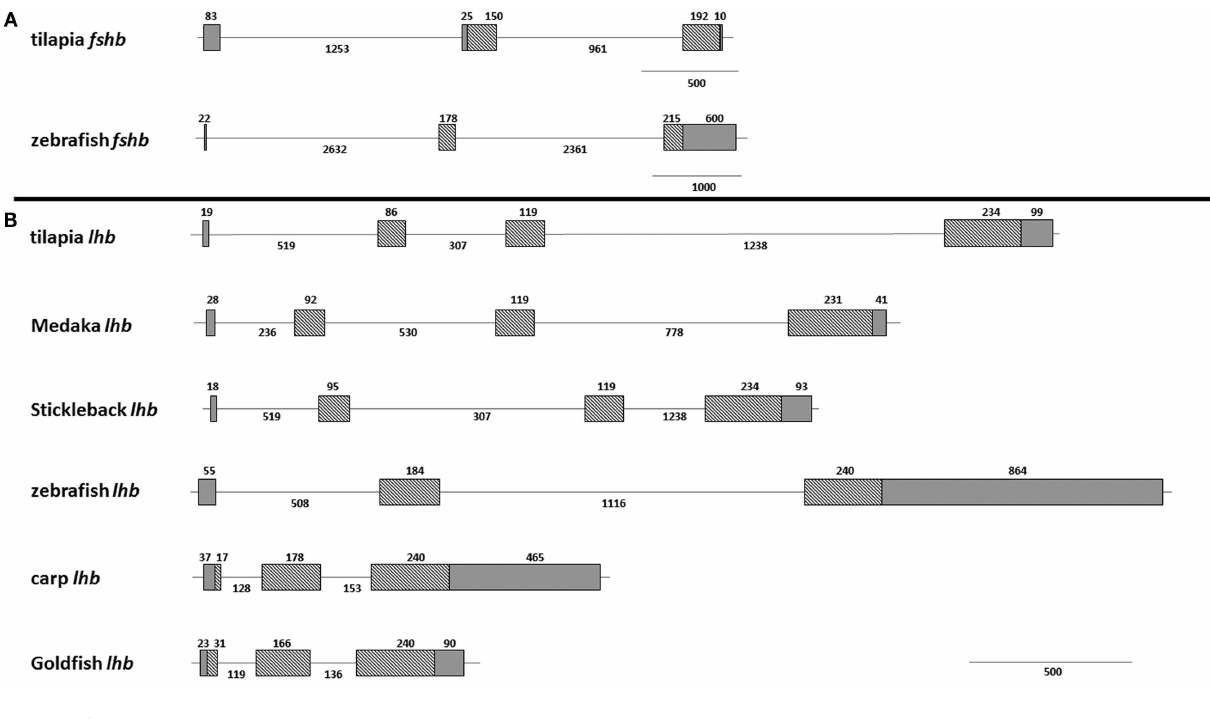
FIGURE 1 | Gene structure of fish gonadotropins . Schematic overview of the exon–intron organization of several fish GtH genes. (A) The fshb genes of tilapia (AY294015.1 and JX887154.1) and zebrafish (NM_205624) are both divided into three exons but vary in intron size and length of untranslated regions. (B) The lhb genes of tilapia (XM_003438349.1) and